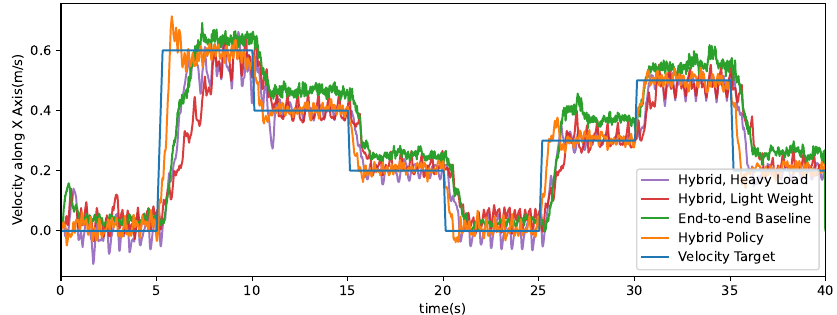
Figure 6. Step respond to step references. Data produced by a simulated robot controlled by different policies to track a predefined reference command signal composed of multiple step